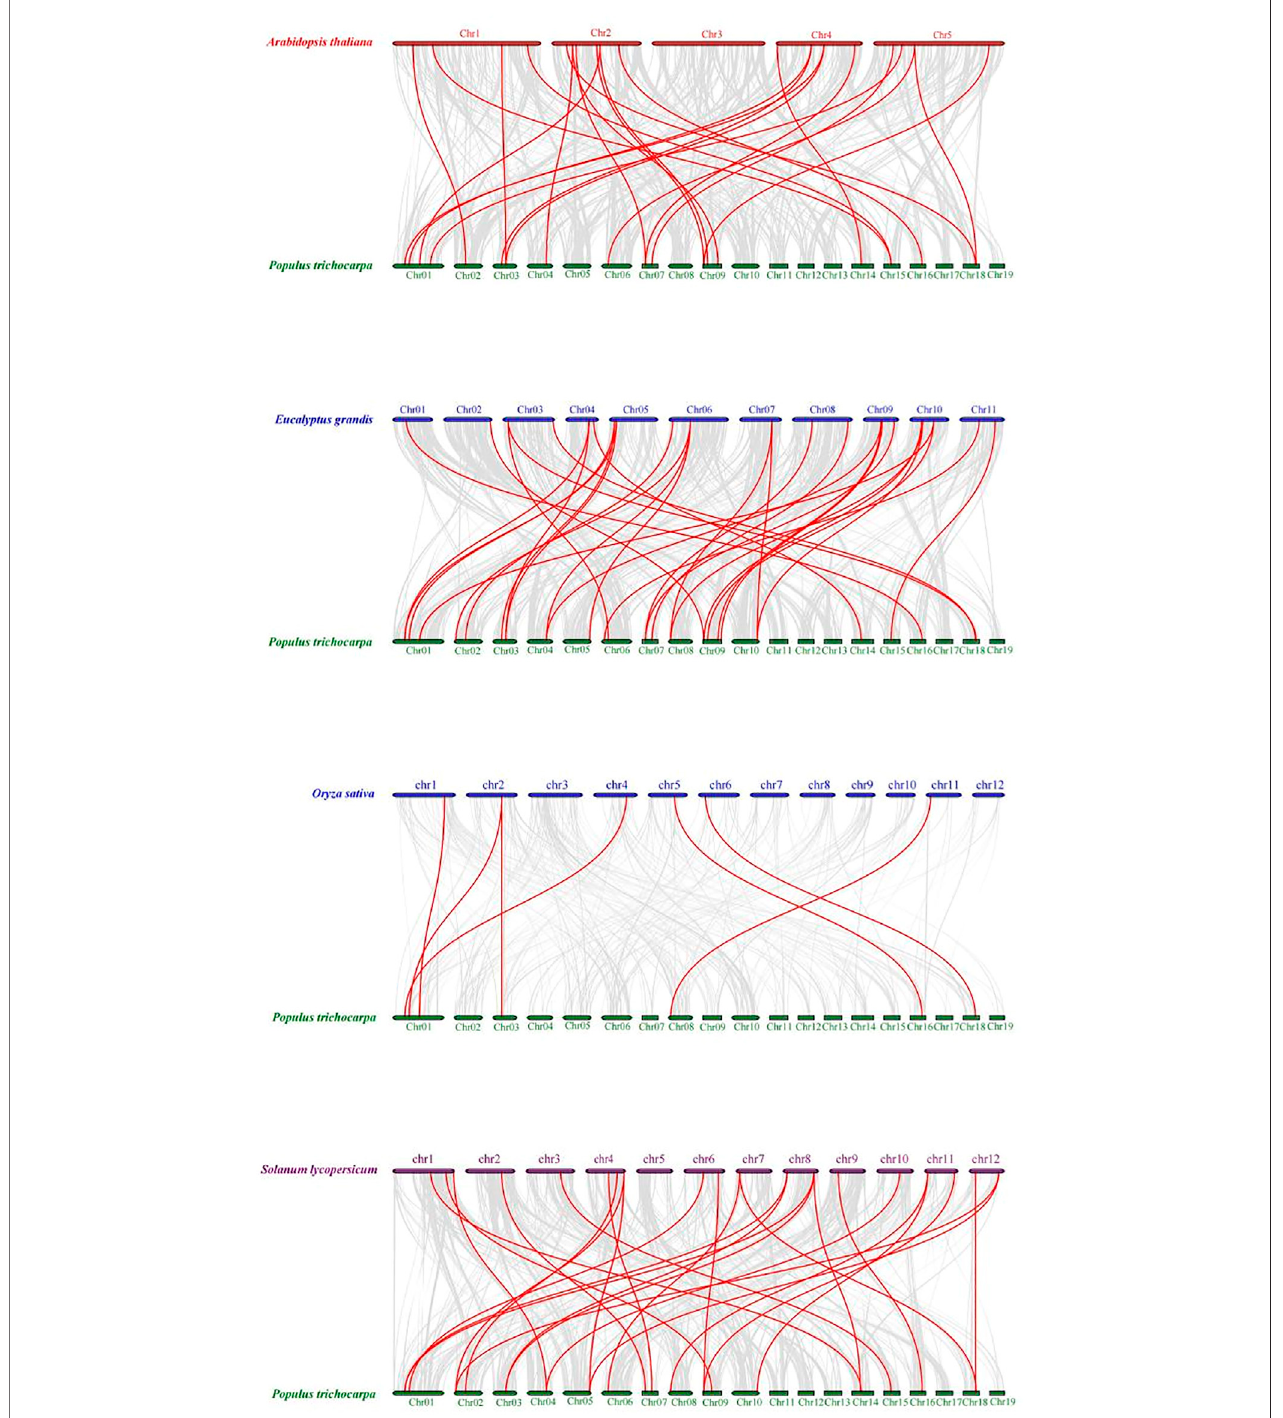
FIGURE7| Collinearity relationship maps of PtrMFS genesin poplar to other four species. Red lines denote collinearity between PtrMFS genesand other species. Gray lines represent collinearity between poplar genome and that are orthologous to the other species.